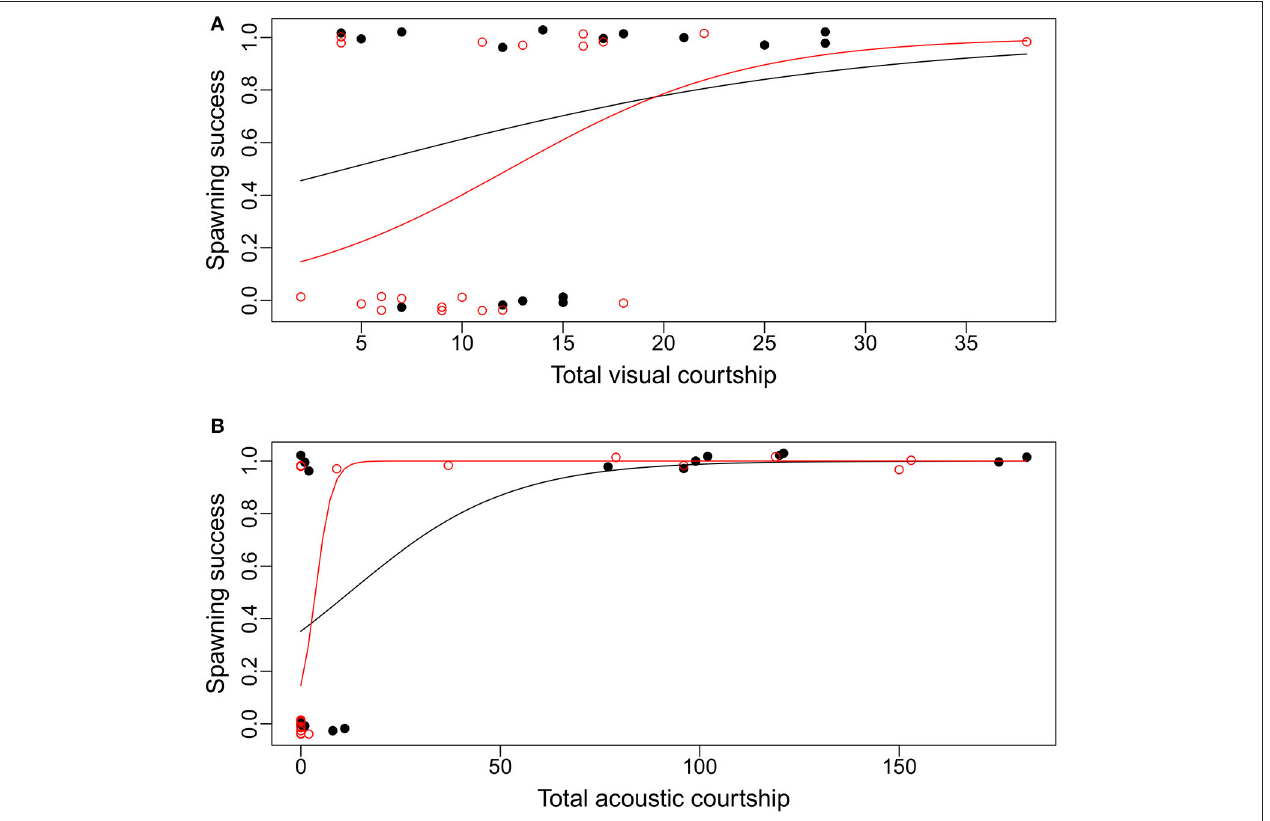
FIGURE 4 | The relationships between visual (A) and acoustic (B) courtship frequency and the probability of spawning success for Painted Goby males in an aquarium experiment to test the effect of additional noise on spawning decisions. Dots are individual males that either did (1) or did not (0) receive eggs from females in the control treatment (black dots) vs. additional noise (red circles). Lines are the model estimates from generalized linear models for the relationship between courtship frequency and spawning success in control (black) vs. additional noise (red). See Supplementary Files for full model